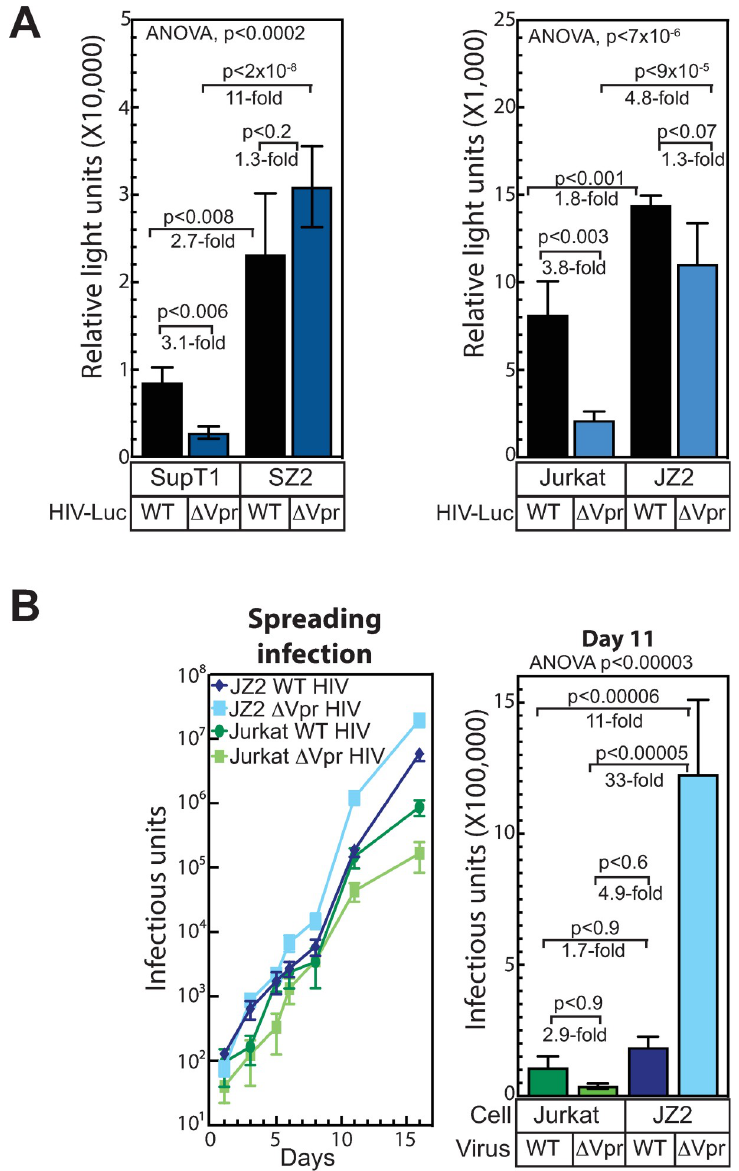
Fig 5. ZBTB2 deletion enhances HIV-1 gene expression and viral replication of VPR knockout strains. (A) WT or Δ ZBTB2 Jurkat and SupT1 cells were challenged with equivalent amounts (based on p24 levels) of either VSV-G pseudotyped HIV-1 vector with nonsense mutations in envelope, luciferase in the NEF locus, and either a WT Vpr or a Vpr nonsense mutant ( Δ Vpr). (B) Replication of WT or Δ Vpr HIV-1 in WT or Δ ZBTB2 Jurkat cells. Cells (1X10 6 ) were infected with the indicated virus at an moi of 0.005. Supernatant was titered in quadruplicate on TZMBL reporter cells at the indicated time points and infectious units counted by X-gal staining. The data shown are the average mean values obtained in an experiment performed with quadruplicate samples and are representative of three independent experiments. The bar graph is a focus on the day 11 time point. Error bars indicate the standard deviation of the data in all panels. ANOVA analysis was performed and for P-values < 0.05 a Tukey’s HSD was performed and relevant P- values